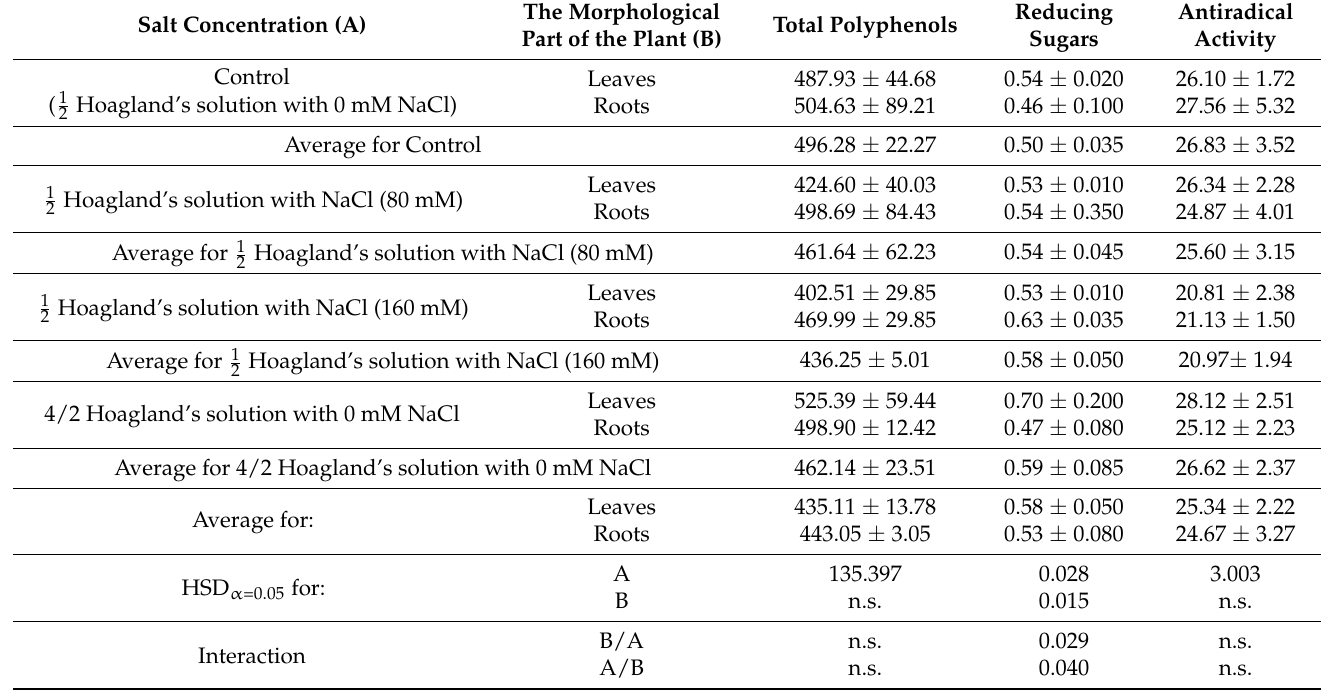
Table 2. The content of total polyphenols (mg GAE g − 1 FW), reducing sugars (% FW), and